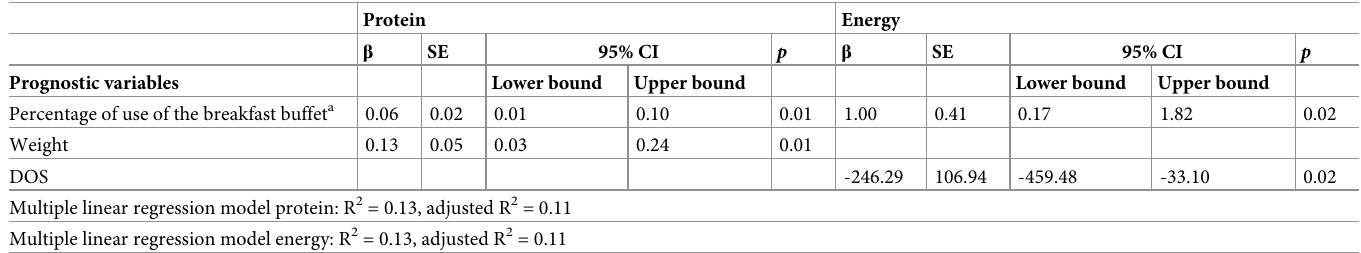
Table 4. The multivariable regression analyses of prognostic factors for protein, energy intake. Protein Energy Prognostic variables Lower bound Upper bound Lower bound Upper